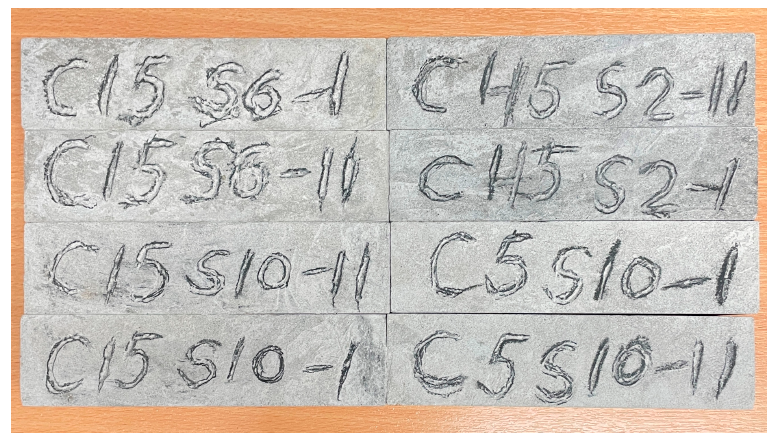
Figure 2. Specimens after 28